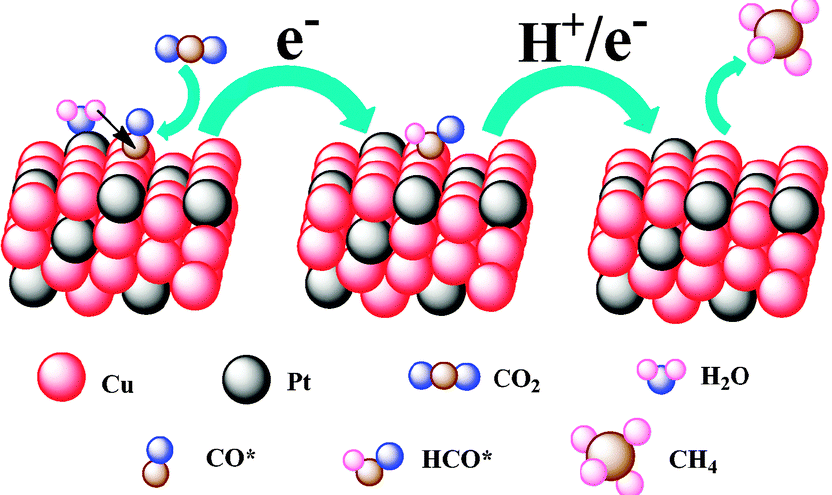
Figure 5. A proposed mechanism illustrating the steps of CO 2 electroreduction and CH 4 formation occurring at the Cu-Pt 3:1 NC catalyst. Reprinted from Ref. [110], copyright (2015), with permission from the Royal Society of Chemistry.